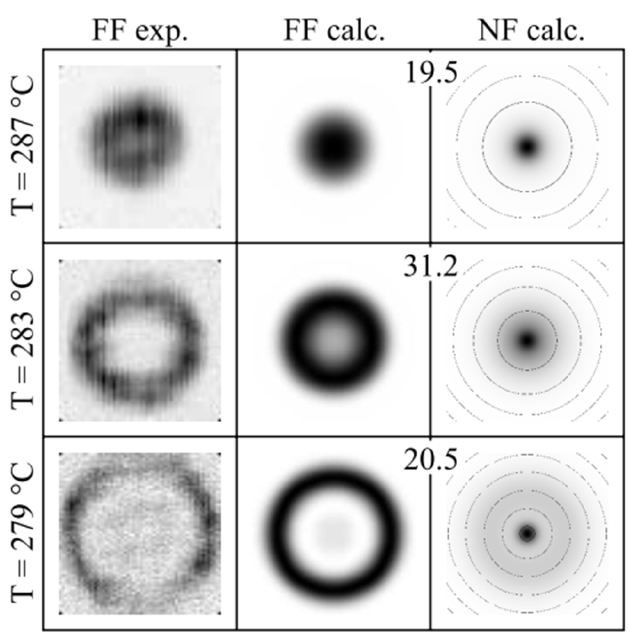
Figure 12. Experimental recordings and computations of the beam profile for three temperatures at normal incidence. Reprinted figure with permission from [144]. Copyright 2001 by the American Physical Society. Spatial mode control of radiation generated by DFG in periodically poled crystals.